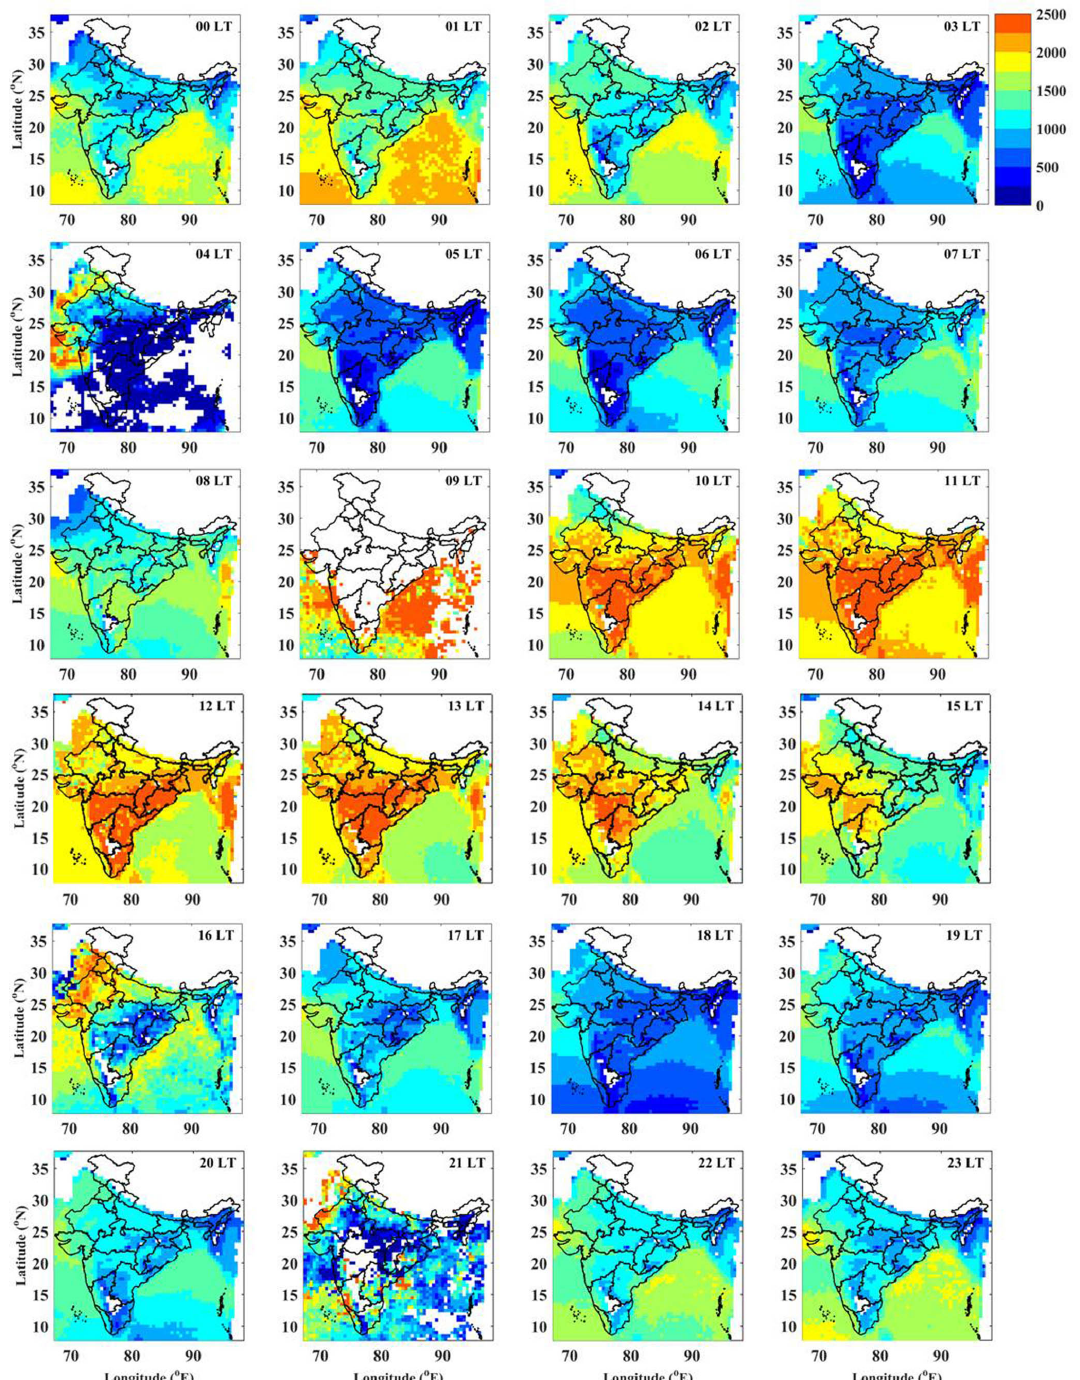
Figure 8. Hourly mean distribution of INSAT-3D CAPE (Jkg − 1 ) during the period from 1 April 2014 to 31 March 2017 over the Indian